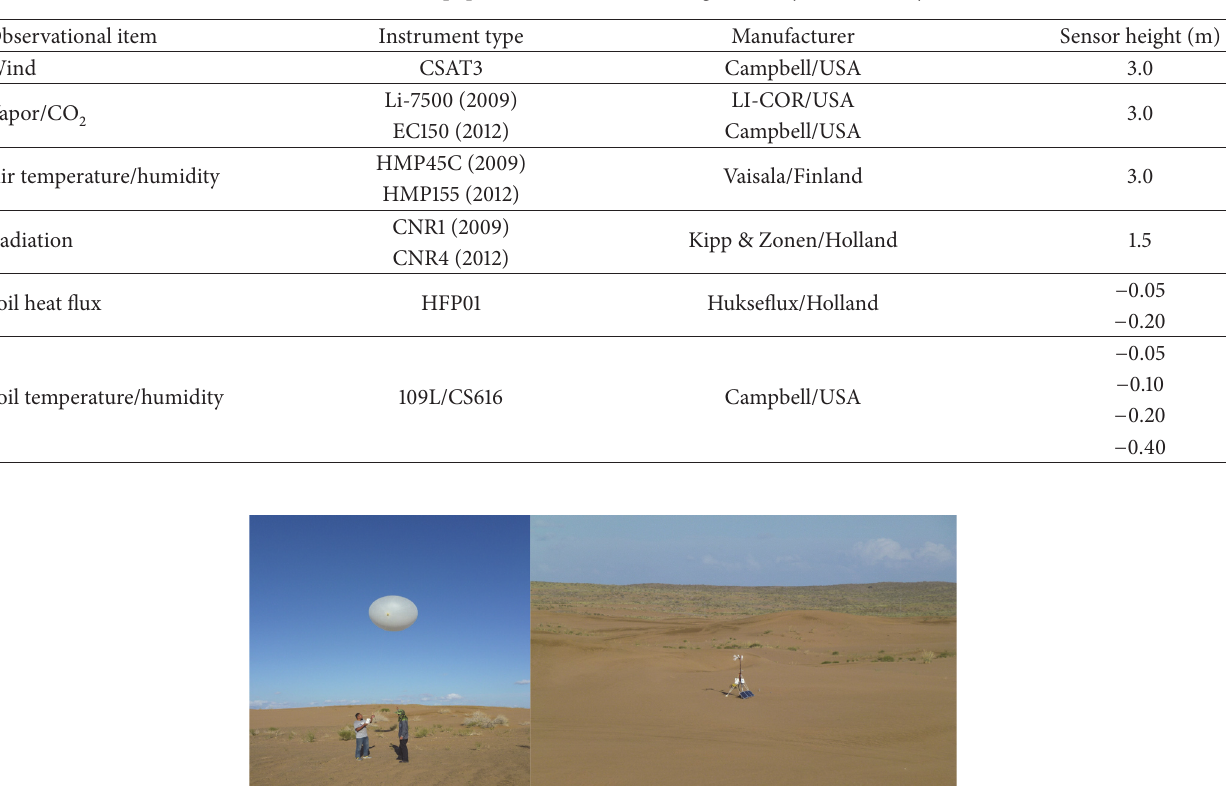
Table 1: Observation equipment and installment height of eddy covariance system.